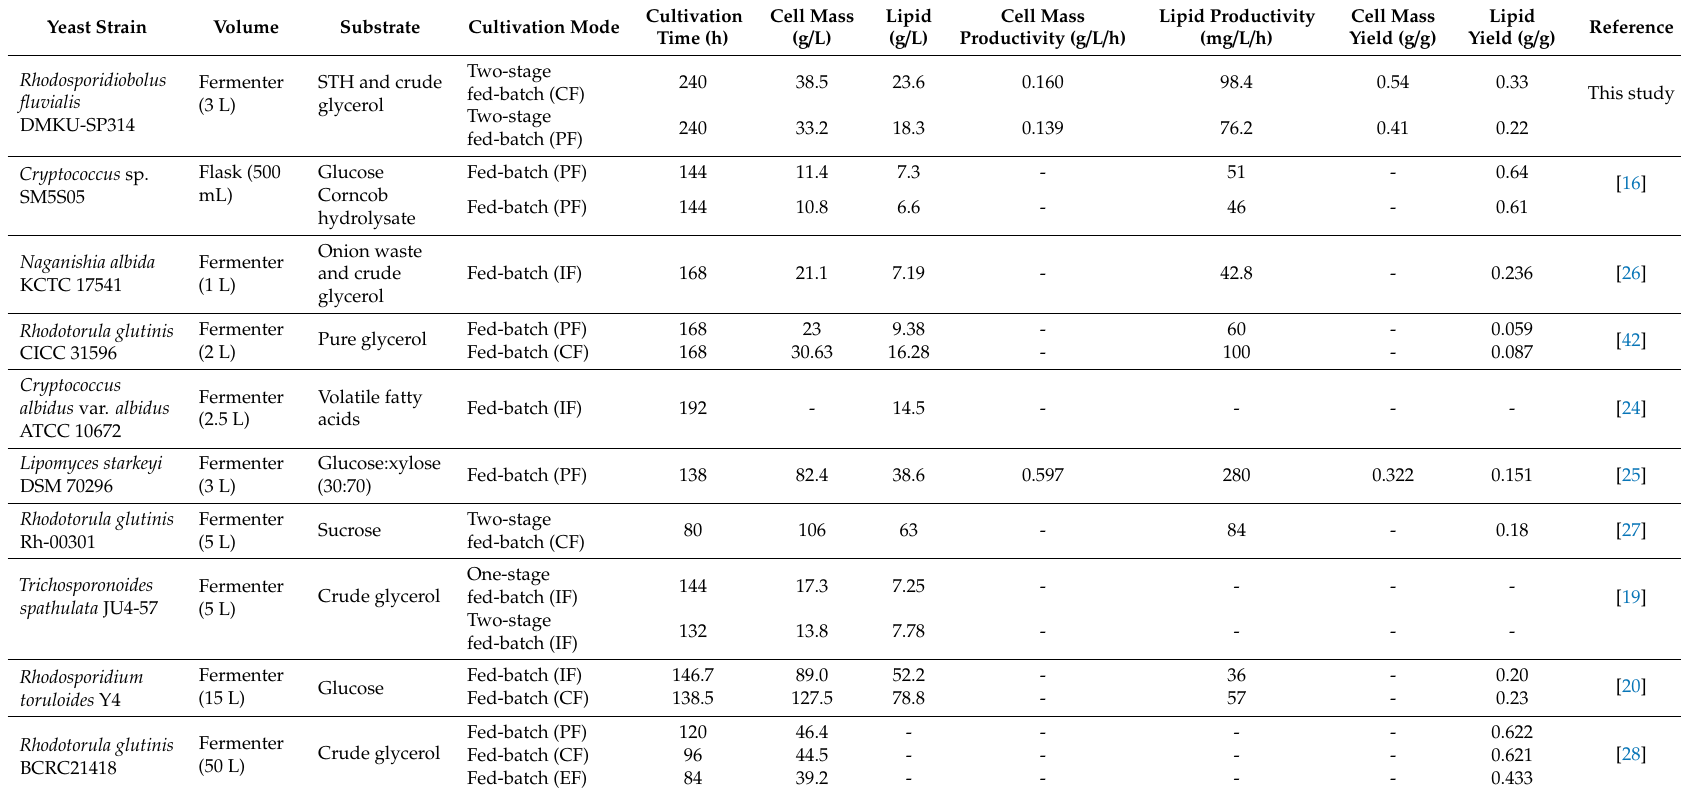
Table 3. Lipid production by various oleaginous yeasts using fed-batch